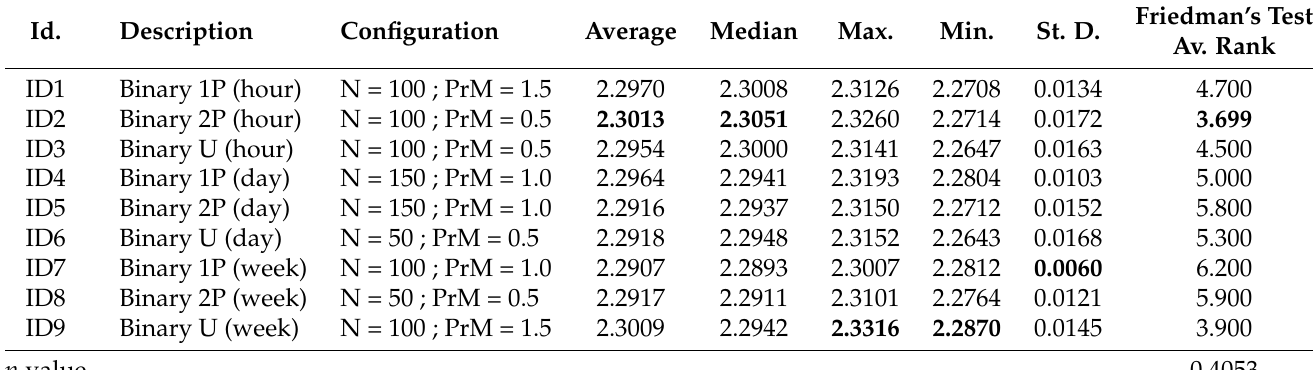
Table 13. Hypervolume statistics (accuracy